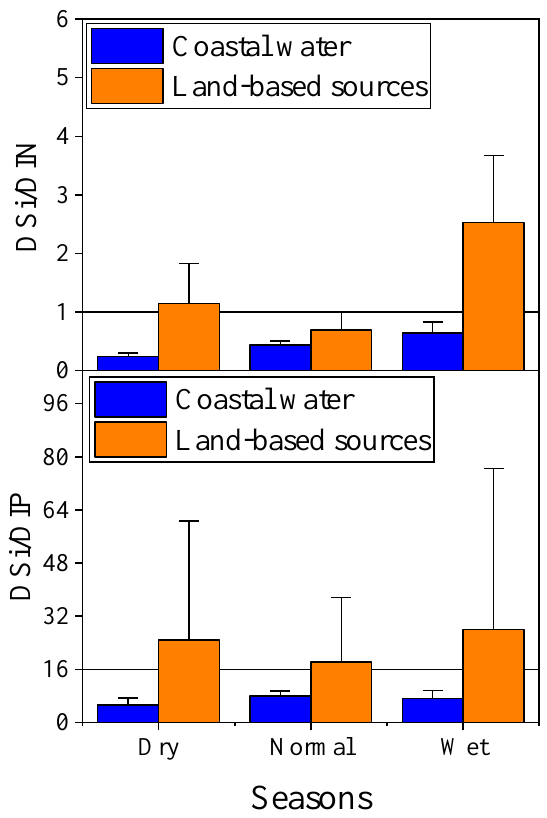
Figure 7. Comparison of DSi / DIN and DSi / DIP between coastal water and land-based sources in Zhanjiang Bay.